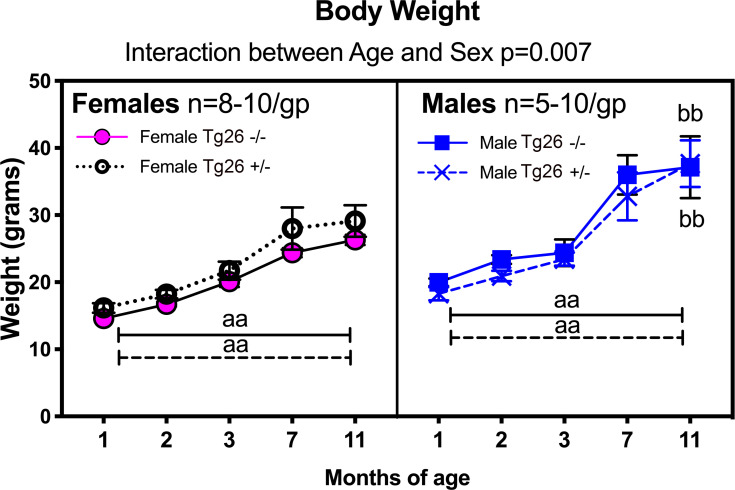
Body weight differences by sex and across time.aa: p<0.01, compared to values obtained for these same animals at 1 mo (same genotype); bb: p<0.01, compared to opposite sex yet same genotype. Numbers/group: At 1 and 2 months of age, there were 10 female wild type -/- mice, 8 female Tg26 +/- mice, 10 male wild type -/- and 10 male Tg26 +/- mice. At 7 months of age, there were 10 female wild type -/- mice, 8 female Tg26 +/- mice, 8 male wild type -/- and 5 male Tg26 +/- mice.